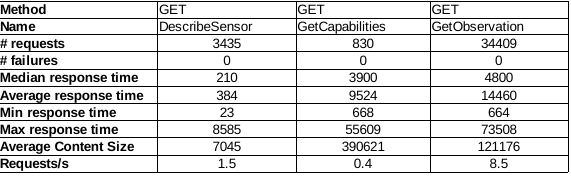
Table 3. VM-0 test results with 200 users.